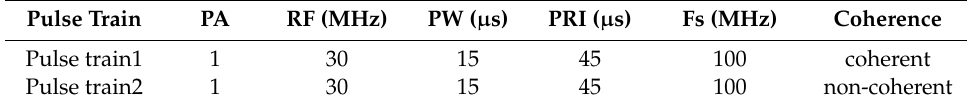
Table 2. Parameters of linear frequency modulation (LFM) signals.